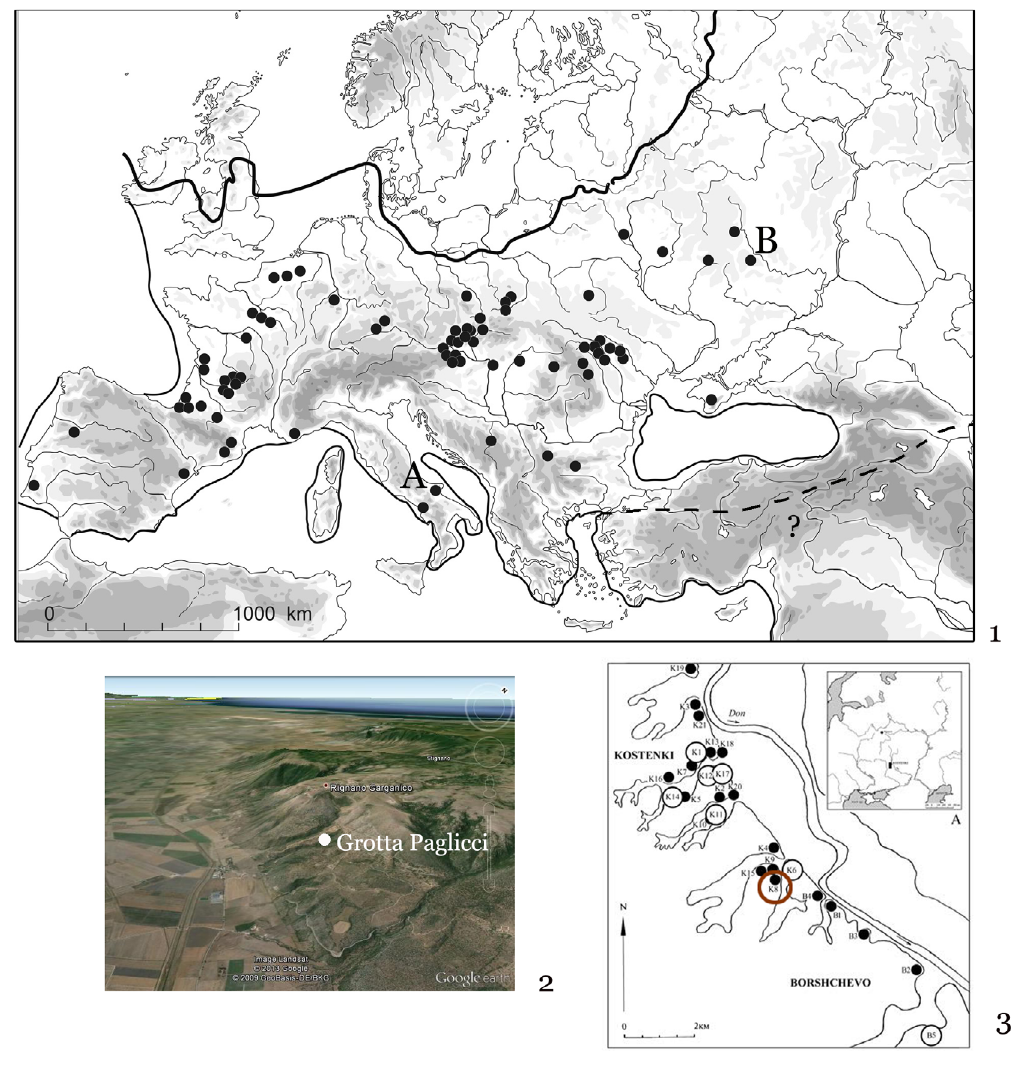
Figure 1. 1) Map of the Gravettian distribution in Europe and principal sites (Modified from Kozłowski, 2015) A: Grotta Paglicci, B: Kostenki. 2) Location of Grotta Paglicci (font: Google Earth). 3) Distribution of sites in the Kostenki–Borshevo area